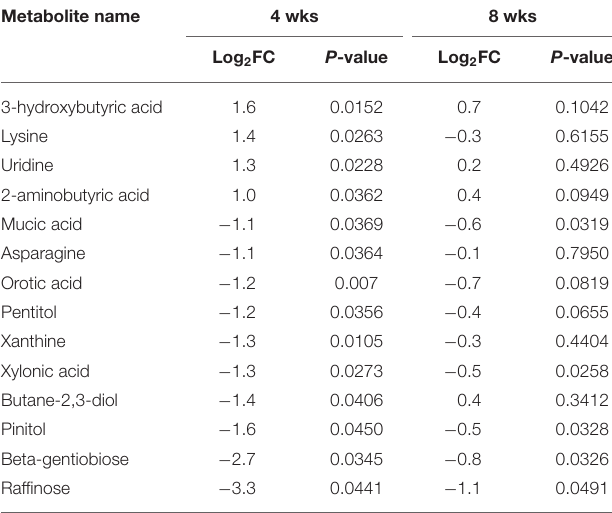
TABLE 3 | Plasma metabolite biomarkers in WB at 4- and 8 wks of age compared to Con. Metabolite